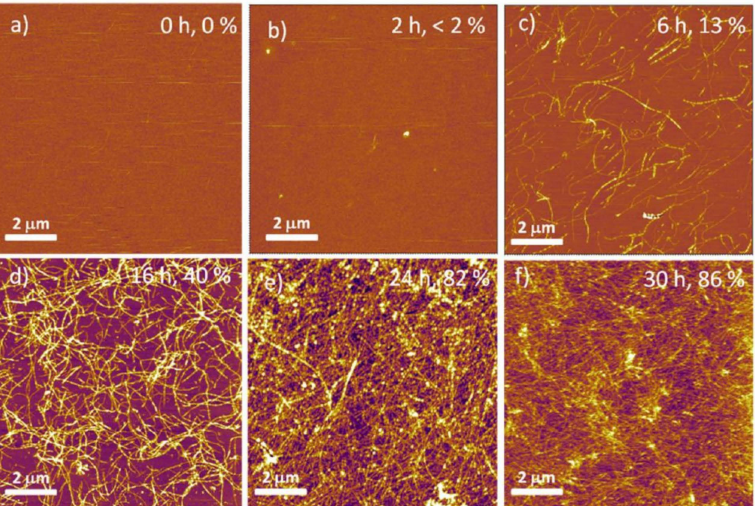
Figure 7. AFM images of ( a ) 2 wt.% lysozyme solution, and ( b – f ) amyloid fibril network from lysozyme solution by incubating fibrillar suspensions onto mica substrates for 10 min. Fibrillar suspensions formed at 90 ◦ C for ( b ) 2 h, ( c ) 6 h, ( d ) 16 h, ( e ) 24 h, and ( f ) 30 h (% coverage also listed on images). Z-scale = 10 nm. Reprinted with permission from [48]. Copyright (2014) American Chemical